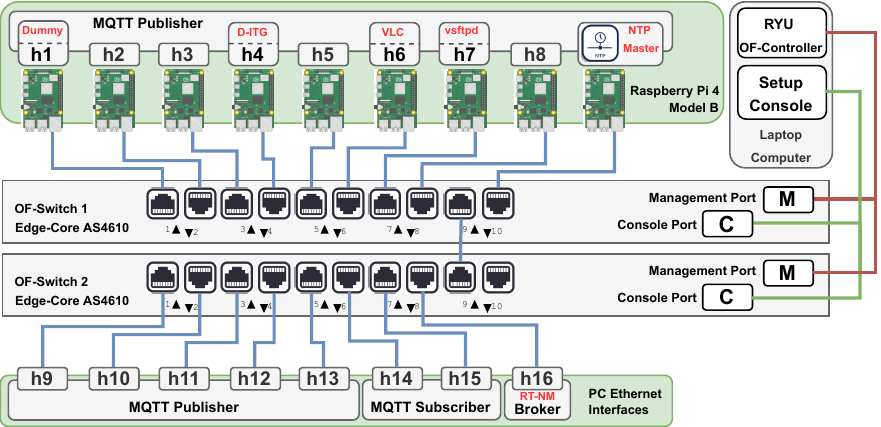
Figure 11. Experimental set-up architecture.